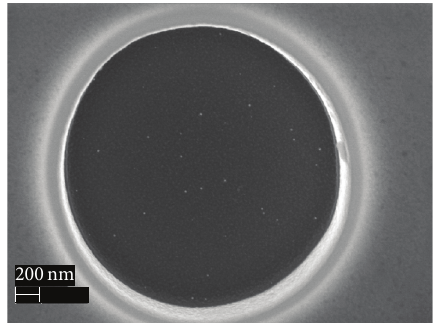
Figure 3: SEM-micrograph of a silicon/silicon oxide substrate after dip deposition of III . On the silicon area (black), particles are seen as small bright spots. The silicon oxide surface almost lack